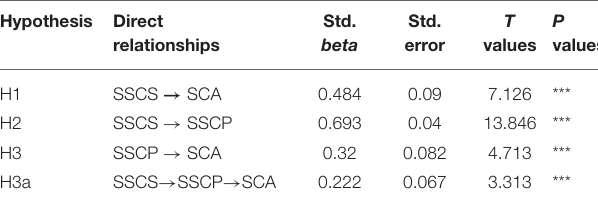
TABLE 4 | Hypotheses testing direct and indirect